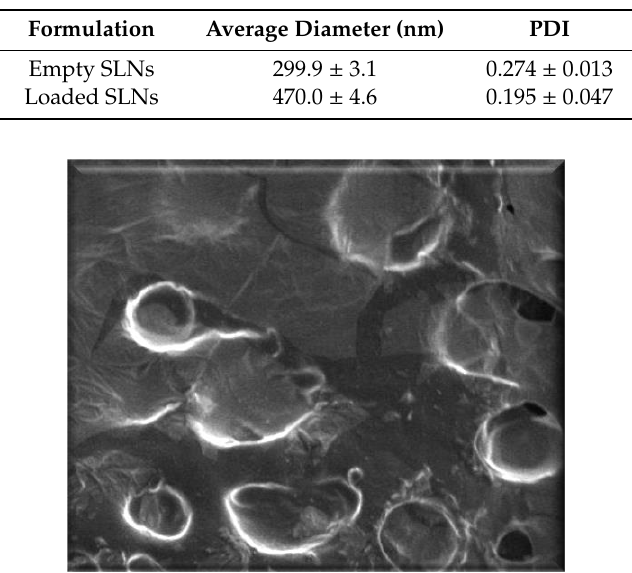
Figure 2. Photomicrography of loaded SLNs observed by